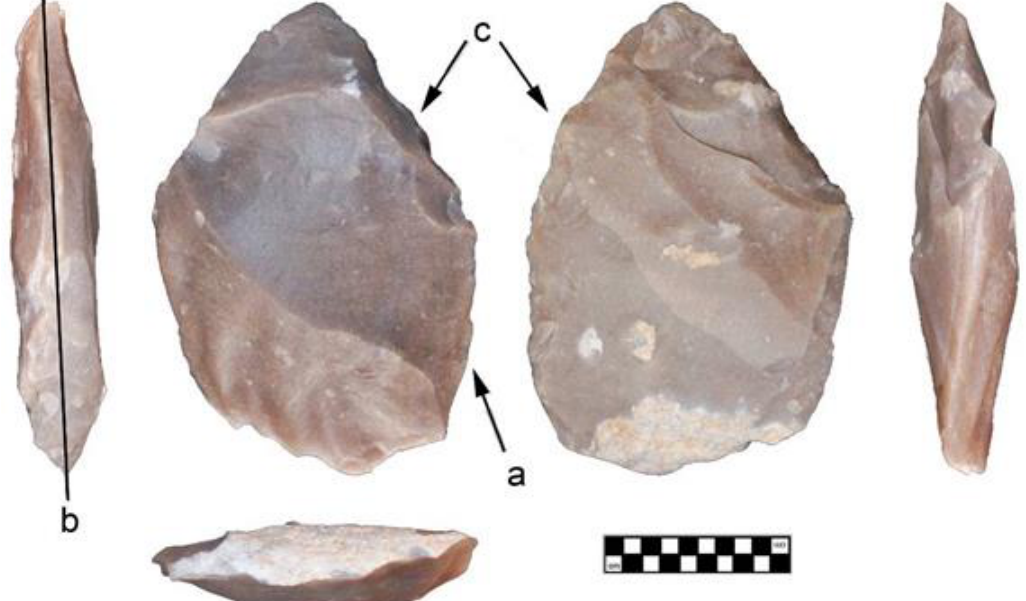
Figure 7. Replica 2 biface after removal of second overshot flake. a) overshot termination; b) resulting biface plane; c) platform prepared for the removal of Flake 3 from the other